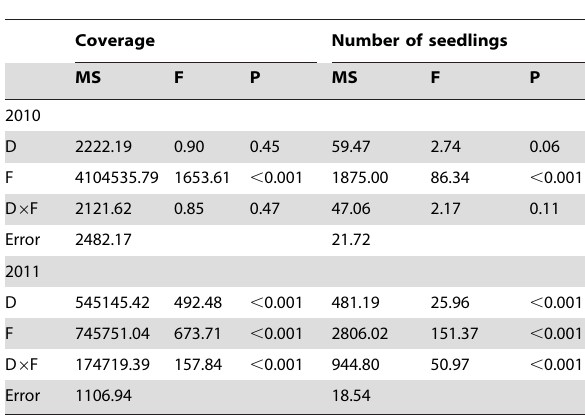
Table 3. Results from two-way ANOVA of effects of dominant functional group (D) and fertilization (F) treatments on the coverage and seedling number of invaders in pots in 2010 and